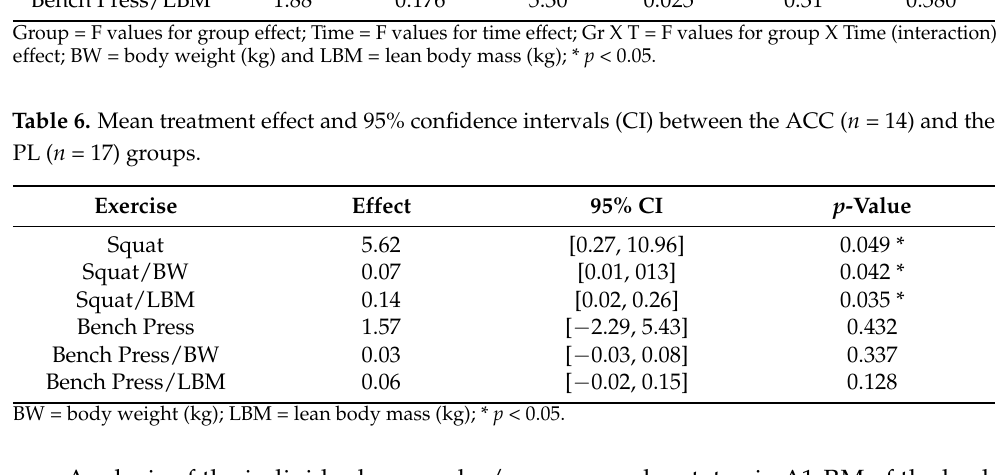
Table 5. RM-ANOVA analysis of 1-RM performance analysis by the ACC ( n = 14) and the PL ( n = 17) groups before and following (pre-post) 8 weeks of training and nutritional intervention. Degrees of Freedom for all analyses = 1, 58. Exercise Group p -Value Time p -Value Gr X T p -Value Squat abs 3.53 0.065 44.06 0.001 * 0.66 0.421 Squat/BW 5.61 0.021 * 19.14 0.001 * 0.22 0.638 Squat/LBM 7.85 0.007 * 40.58 0.001 * 0.77 0.385 Bench Press abs 0.64 0.429 7.48